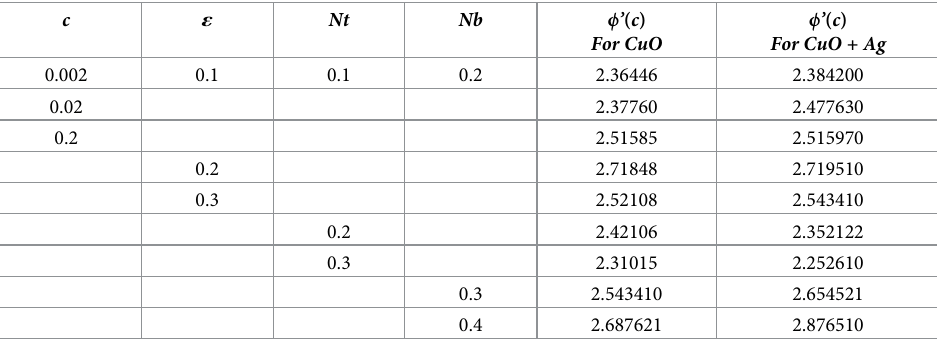
Table 6. Influence of various parameters on coefficient of the Sherwood ϕ’ ( c ) when Pr =